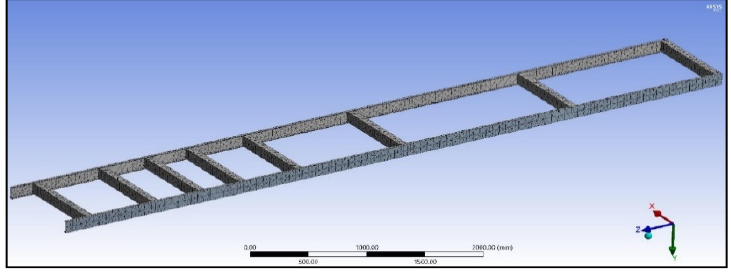
Figure 4. Meshed model of HMV chassis.